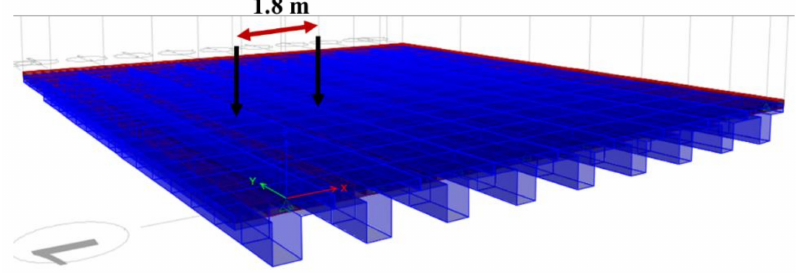
Figure 7. Finite element modelling of a group of nine